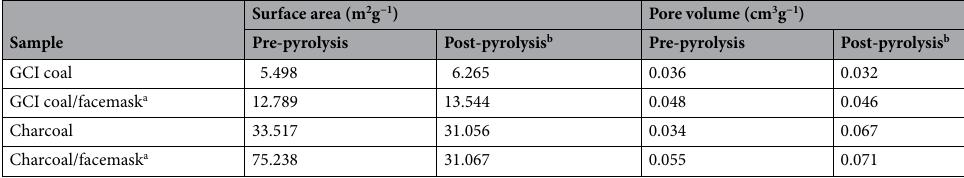
Table 1. Surface area (BET) and pore volume (DFT) analysis for pre- and post-pyrolysis of samples carbon and carbon/facemask samples. a 20 wt.% facemask added to the carbon source. b 500 °C in argon.